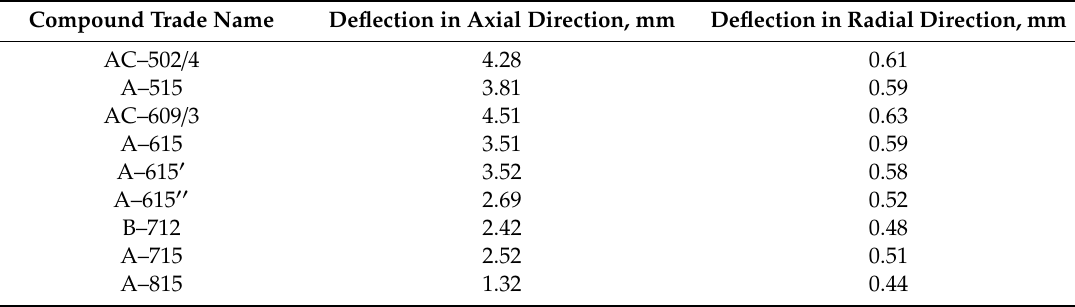
Table 7. Results of the virtual experiment performed by axial and radial load